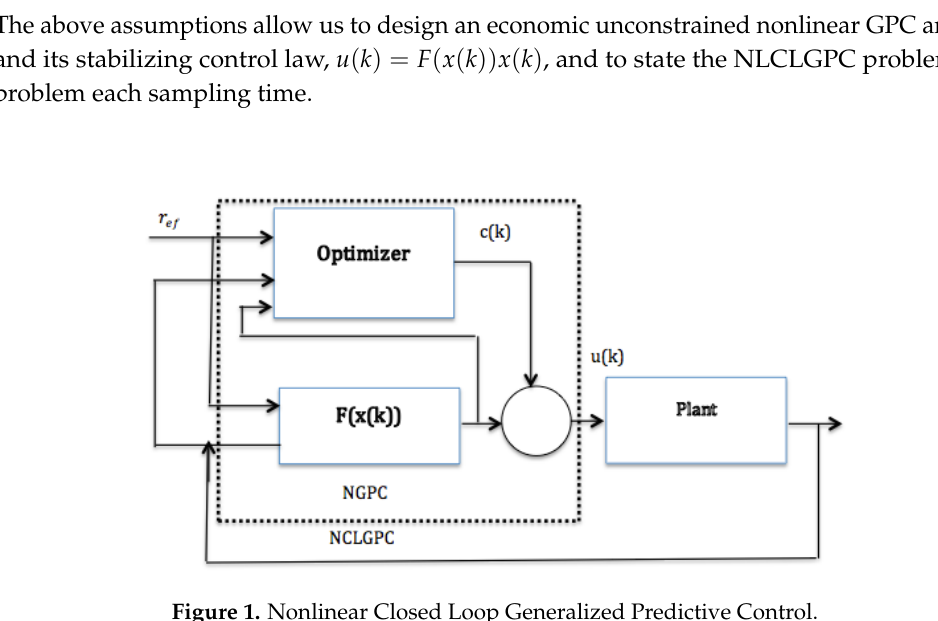
Figure 1. Nonlinear Closed Loop Generalized Predictive